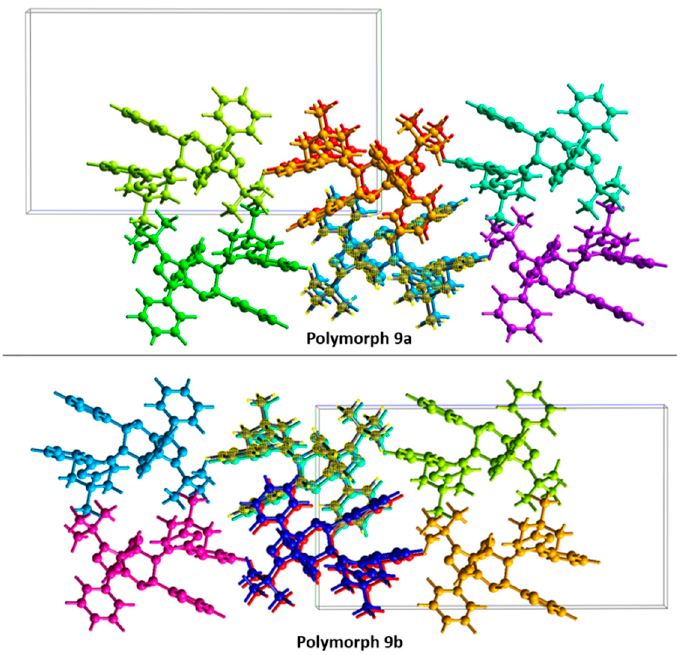
Figure 13. Clusters used for calculating interatomic energies between a unique pair of molecules in crystals 9a and 9b with the CE-B3LYP model. The central molecule is highlighted in a yellow mesh and unique symmetry-related molecules are presented in different colors.